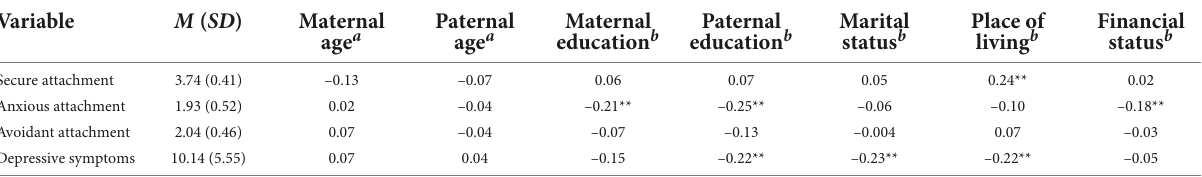
TABLE 8 Pearson’s linear correlation coefficients and point-two-series correlation coefficients for the relationship of maternal adult attachment and sociodemographic variables. Variable M ( SD